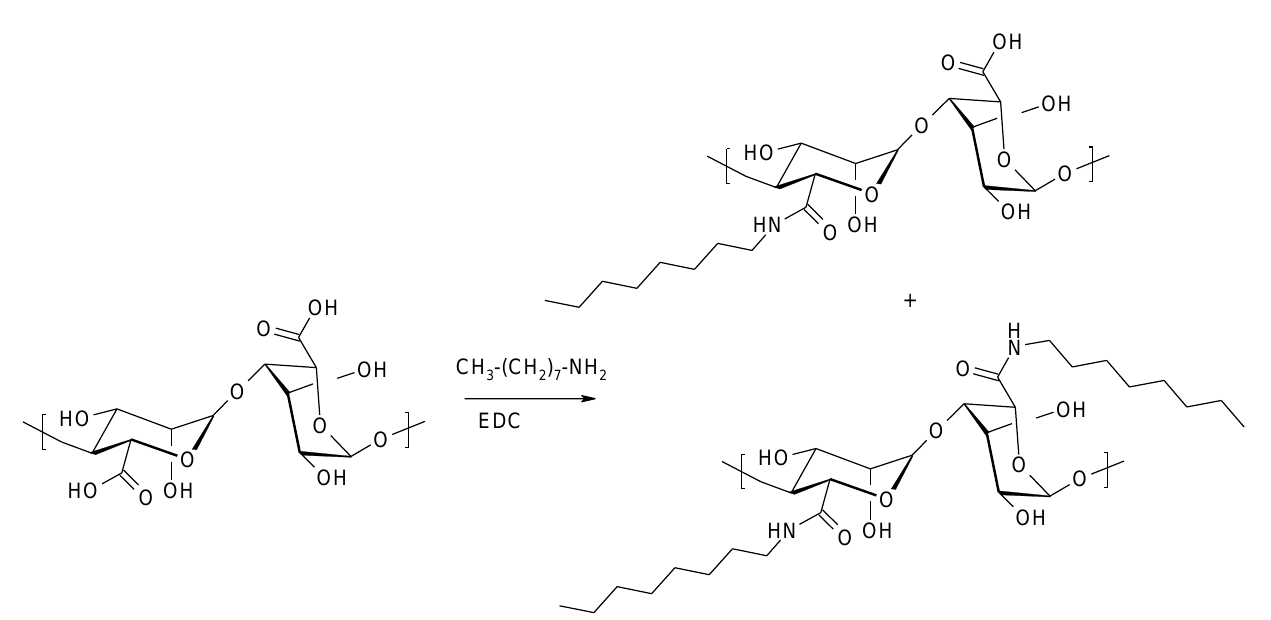
Figure 18. Formation of N -octylamide of alginic acid using EDC as a condensing agent. Water-soluble EDC-HCl has been used to obtain a variety of amide derivatives of alginic acid [112–116].